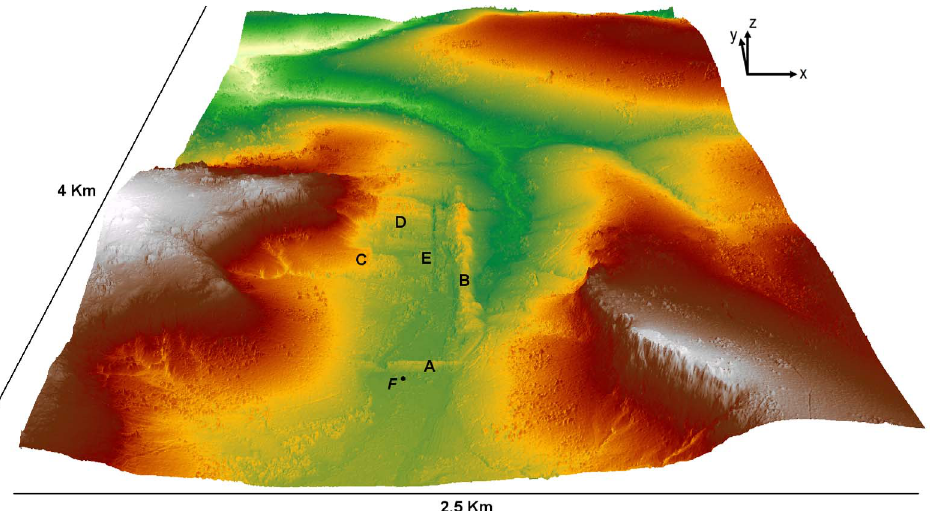
Figure 2. Lidar digital terrain model of Phnom Kulen Plateau centered on Thnal Mrech dyke. Lidar digital terrain model of the main valley of Phnom Kulen Plateau with 1 m resolution and 4 6 vertical exaggeration. A: Thnal Srae Thbong; B: Thnal Mrech; C: NS cut bedrock; D: EW extraction lines; E: channel; F: Sediment core sampling (Imagery: Ste´phane De Greef/Archaeology and Development Foundation).